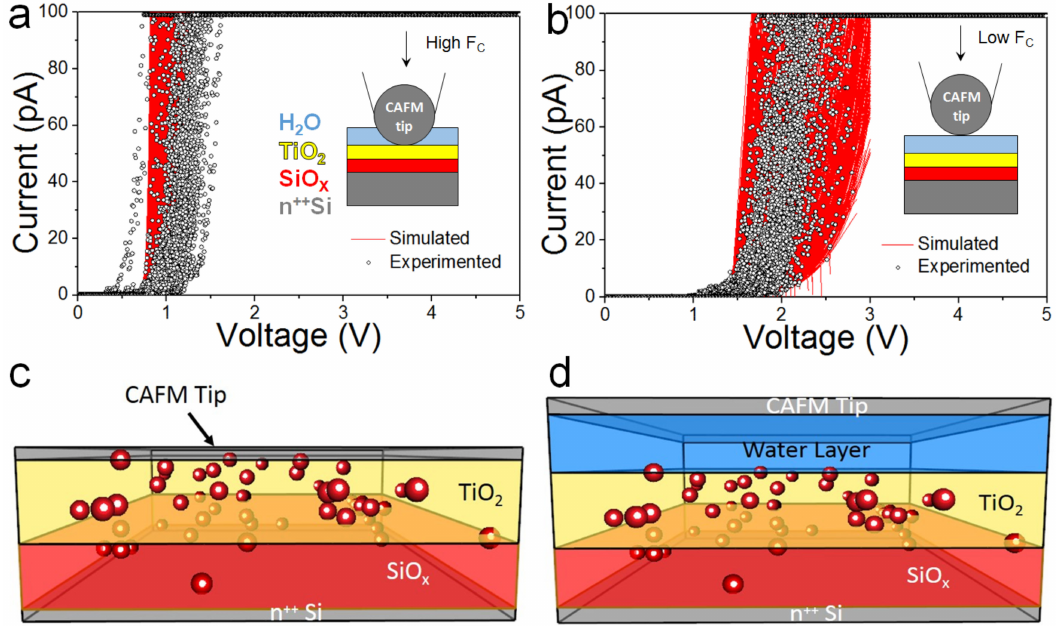
Figure 4. Experimental I-V curves recorded at different locations of the TiO 2 /SiO x /n ++ Si samples using ( a ) a SCM-PIT and ( b ) a PFTUNA tip, and their corresponding fittings using Ginestra TM software. The experimental curves correspond to those in Figure 2a,b. Several simulated curves are displayed to reproduce intrinsic variability of the experiments (density of traps, thickness of each layer, and tip/sample contact area). The inset images in ( a ) and ( b ) are the schematics of each configuration. ( c ) and ( d ) show the schematics provided by Ginestra TM software for the SCM-PIT/TiO 2 /SiO x /n ++ Si and the PFTUNA/H 2 O/TiO 2 /SiO x /n ++ Si structures. Red spheres in the TiO 2 and SiO x layers represent intrinsic